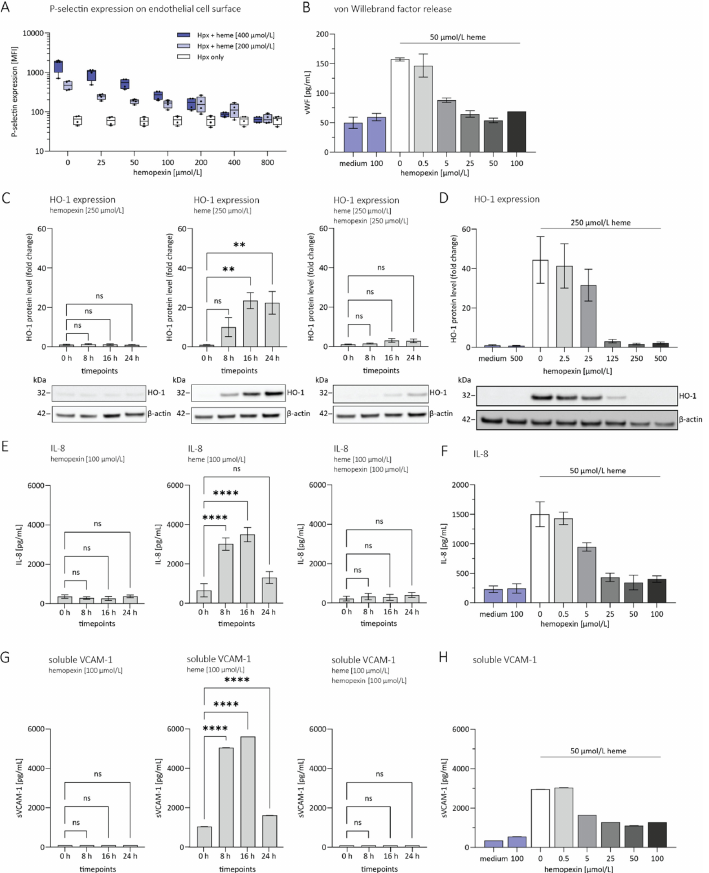
Figure 1. Hemopexin protects human endothelial cells from heme-driven activation and damage in vitro. ( A ) Cell surface P-selectin expression on human umbilical vein endothelial cells (HUVECs) upon stimulation with heme. HUVECs were incubated in different concentrations of hemopexin prior to stimulation with two concentrations of heme (400 and 200 µmol/L) for 25 min. Cell surface P-selectin expression was analyzed by flow cytometry. Data are presented as mean fluorescence intensity (MFI) visualized as Box and whiskers plots representing means ± min to max. Cumulative data of four independent experiments are shown. ( B ) Release of von Willebrand factor (vWF) upon heme stimulation (50 µ mol/L) for 16 h in the presence of various concentrations of hemopexin (0–100 µ mol/L). Data are expressed as the mean from three replicates ± SD. Blue bars: medium and hemopexin control, grey: heme stimulated HUVECs in presence of increasing concentration of hemopexin. ( C ) The plots represent HO-1 protein expression upon stimulation in presence of hemopexin, heme or the combination of hemopexin and heme assessed at different time points (0, 8, 16 and 24 h). Data are expressed as mean intensity ± SD from three independent experiments and a representative Western Blot figure is provided below each data plot. Concentrations are indicated for each plot. ( D ) Dose-dependent prevention of HO-1 expression at different concentrations of hemopexin (0–500 µ mol/L) at a constant concentration of heme (250 µ mol/L) after 16 h of stimulation was investigated. Data are expressed as mean intensity ± SD from three independent experiments and a representative Western Blot figure is provided below. ( E , G ) Heme-stimulated HUVECs released IL-8 and soluble VCAM-1 in a time-dependent manner. Time points investigated were 0, 8, 16 and 24 h and data are represented as mean ± SD from three replicates. ( F , H ) The release of IL-8 and soluble VCAM-1 after 16 h upon heme stimulation (50 µ mol/L) in the presence of various concentrations of hemopexin was investigated (0–100 µ mol/L). Data are expressed as the mean from three replicates ± SD. Blue bars: medium and hemopexin control, grey: heme stimulated HUVECs in the presence of increasing concentration of hemopexin. ** p < 0.01, **** p < 0.0001 versus control (cell culture medium). ns = not